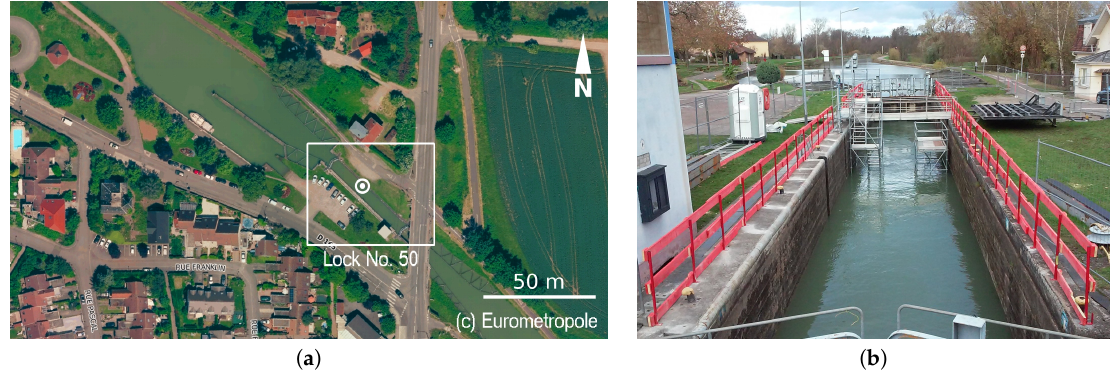
Figure 1. Presentation of Lock No. 50 on the Marne-Rhine canal. ( a ) aerial view (WGS84 coordinates of the white circled dot: 48.6338 ◦ N, 7.7537 ◦ E); ( b ) view of the lock during emptying